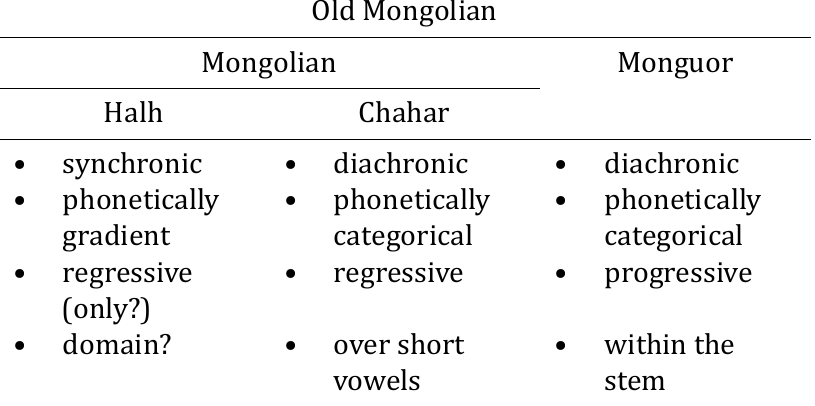
Table 4: Three patterns of dissimilation in the Mongolic